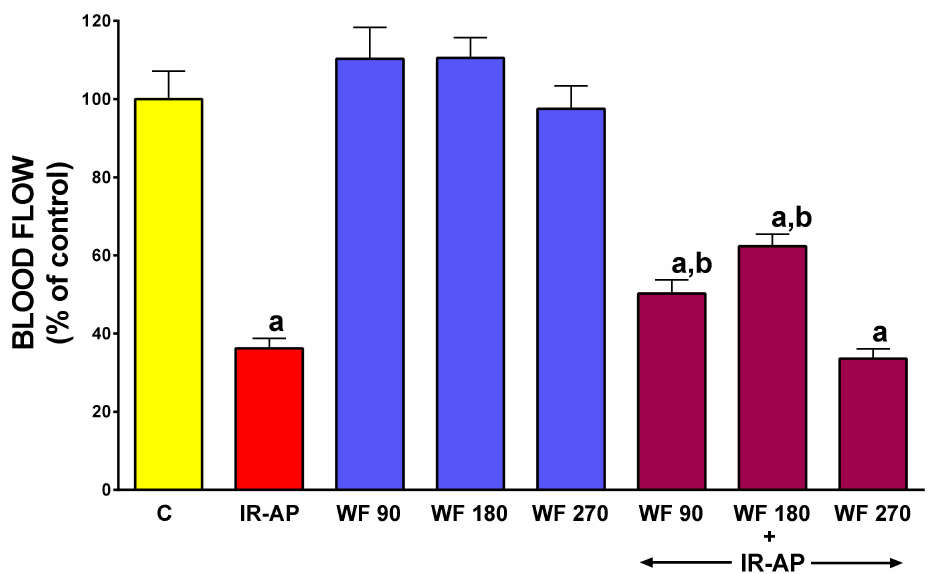
Figure 6. Impact of ischemia / reperfusion-induced acute pancreatitis (IR-AP) or / and pretreatment with warfarin given at a dose of 90, 180 or 270 µ g / kg / dose (WF 90, WF 180 or WF 270) on pancreatic blood flow. Mean ± SEM. n = 10 animals in each experimental group. a p < 0.05 compared to control (C), b p < 0.05 compared to